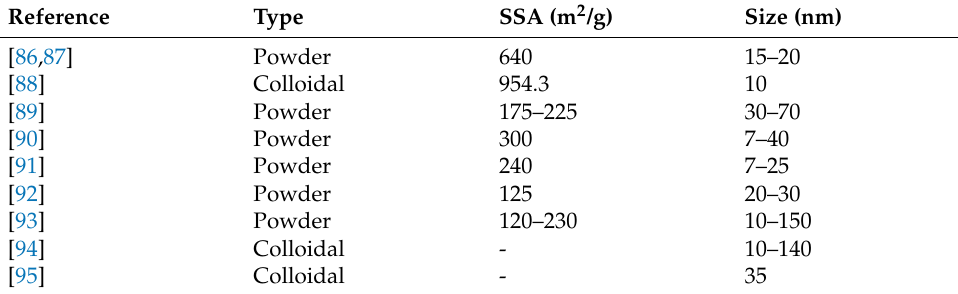
Table 2. Physical properties of nano-silica from the literature.